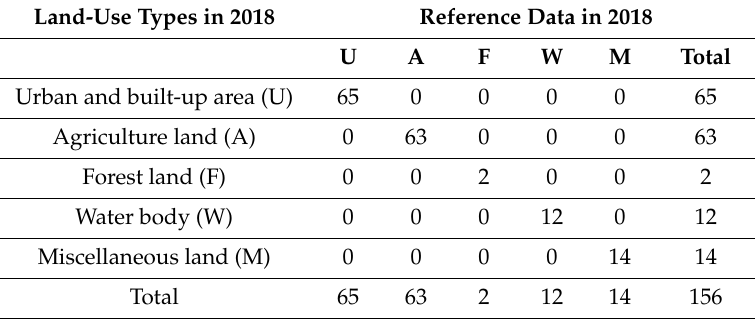
Table A4. Error matrix for accuracy assessment of land-use types in 2018. Land-Use Types in 2018